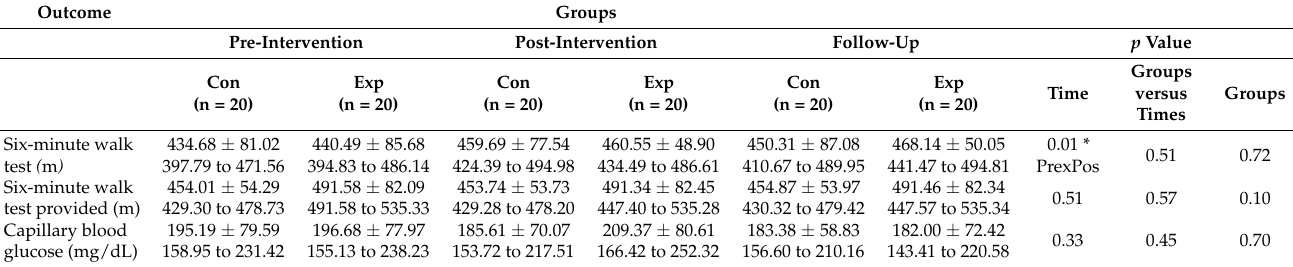
Table 2. Mean, SD, and CI (95%) of groups, difference within groups, difference between groups of the variables six-minute walk test, six-minute walk test provided, and capillary blood